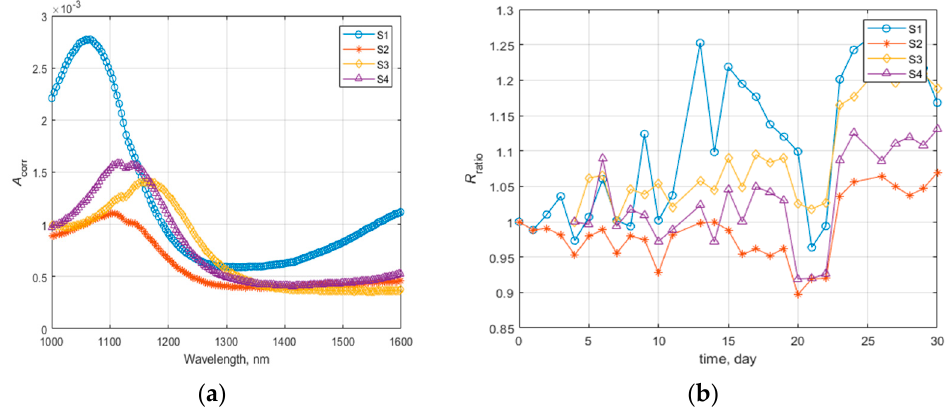
Figure 8. ( a ) Autocorrelation spectra (main diagonal of the 2D-COS synchronous spectrum) of samples with the Ag electrode (S1, S2, S3 and S4); excited from the foil side. ( b ) The R ratio vs. time.